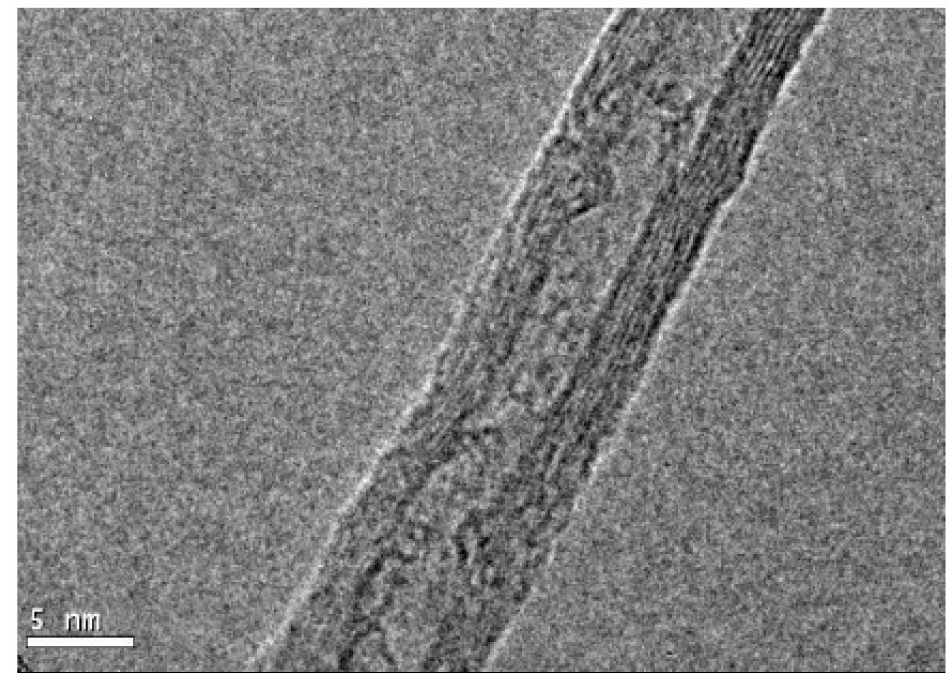
Figure 1. Carbon nanotubes obtained by transmission electron